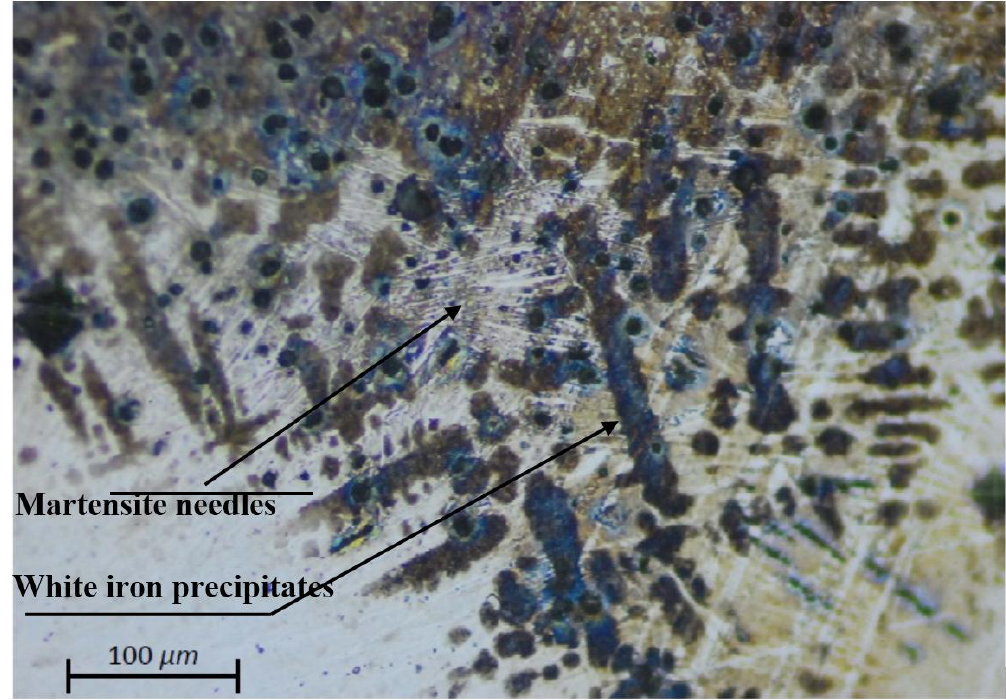
Figure 1. Micrograph of the ductile iron tungsten inert gas (TIG) root weld using Inconel 625 and without subsequent annealing.